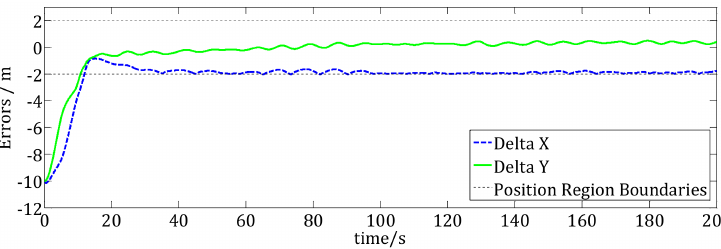
Figure 14. Position errors of the USV under the traditional RC method.